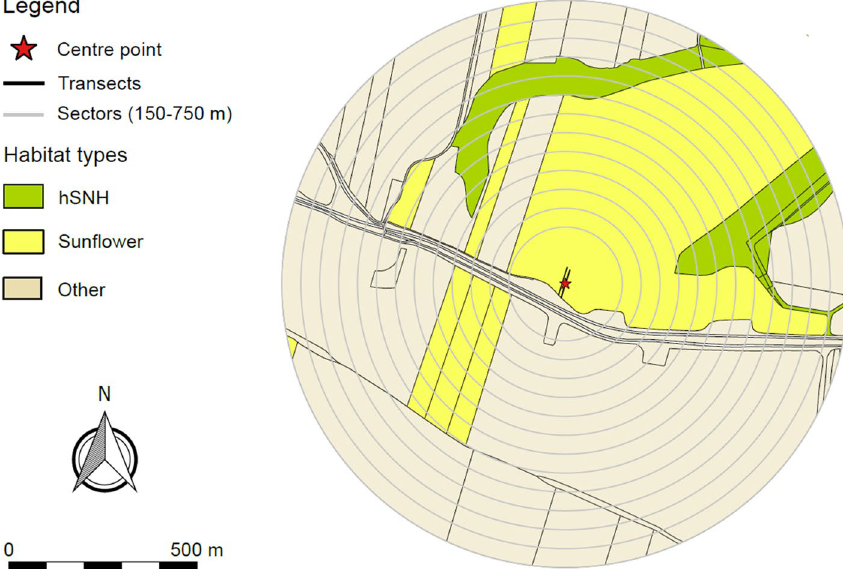
Figure 3. Example for a landscape sector with a composition of landscape elements typical for the study area. The vector map of the landscape sector was created with the software QGIS 2.18.9 (http:// qgis. osgeo. org) 76